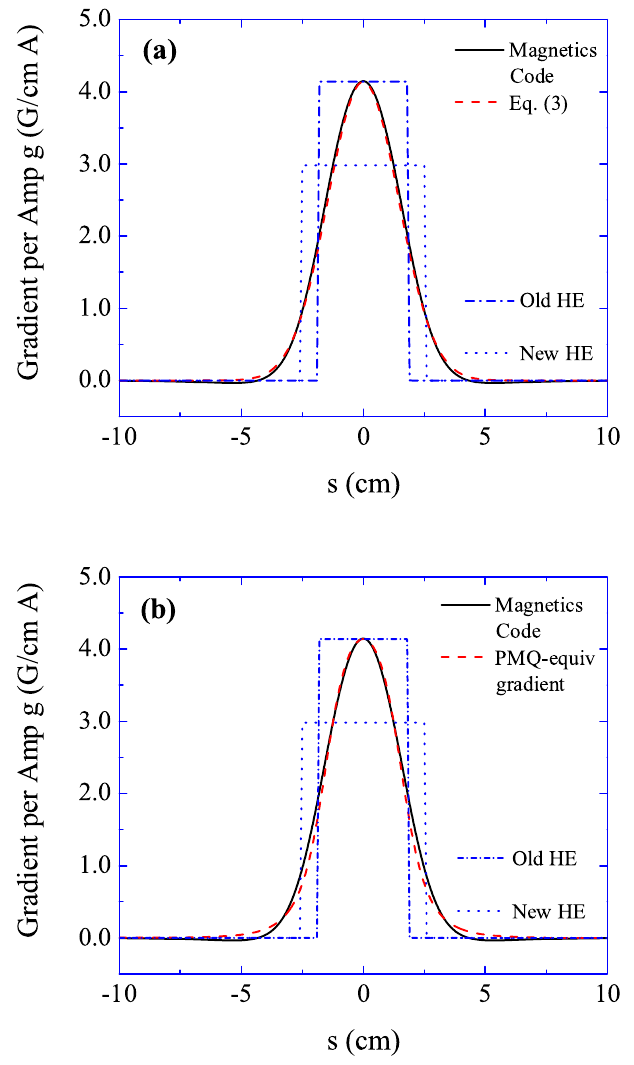
FIG. 2. (Color) On-axis gradient (per Amp) profile of UMER air-core, printed-circuit quadrupole (2nd generation): (a) calcu- lated, analytical, and hard-edge (HE) profiles, and (b) calculated, PMQ-equivalent gradient, and hard-edge (HE)